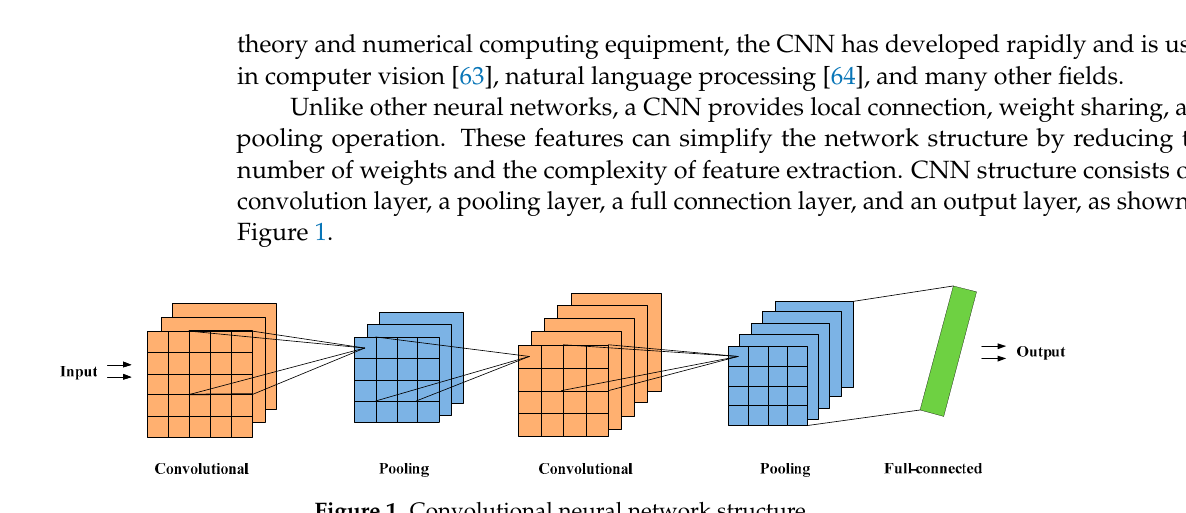
Figure 1. Convolutional neural network structure.